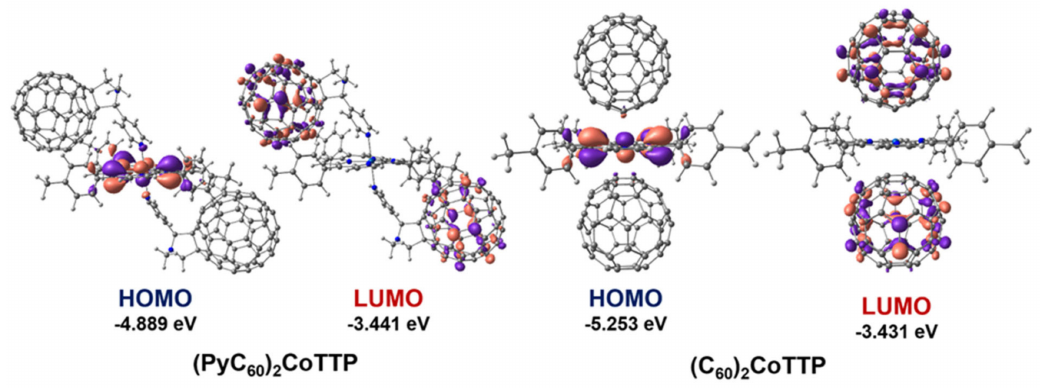
Figure 11. The FMOs in (PyC 60 ) 2 CoTTP ( left ) and (C 60 ) 2 CoTTP ( right